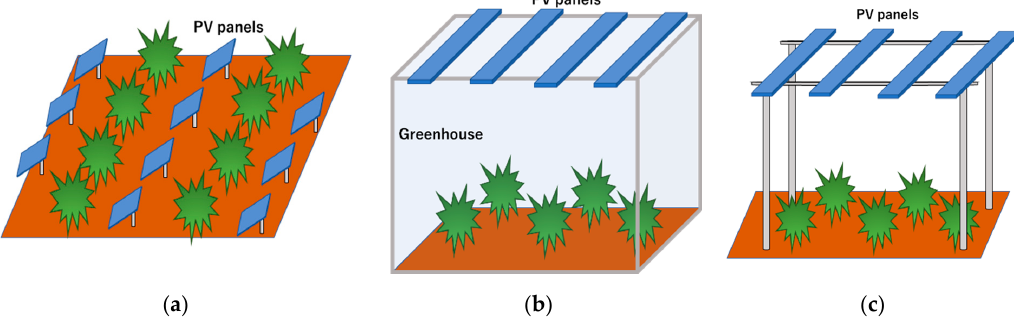
Figure 1. Three different types of agrivoltaic system: ( a ) using the space between photovoltaic (PV) panels for crops, ( b ) a PV greenhouse, and ( c ) a stilt-mounted system.